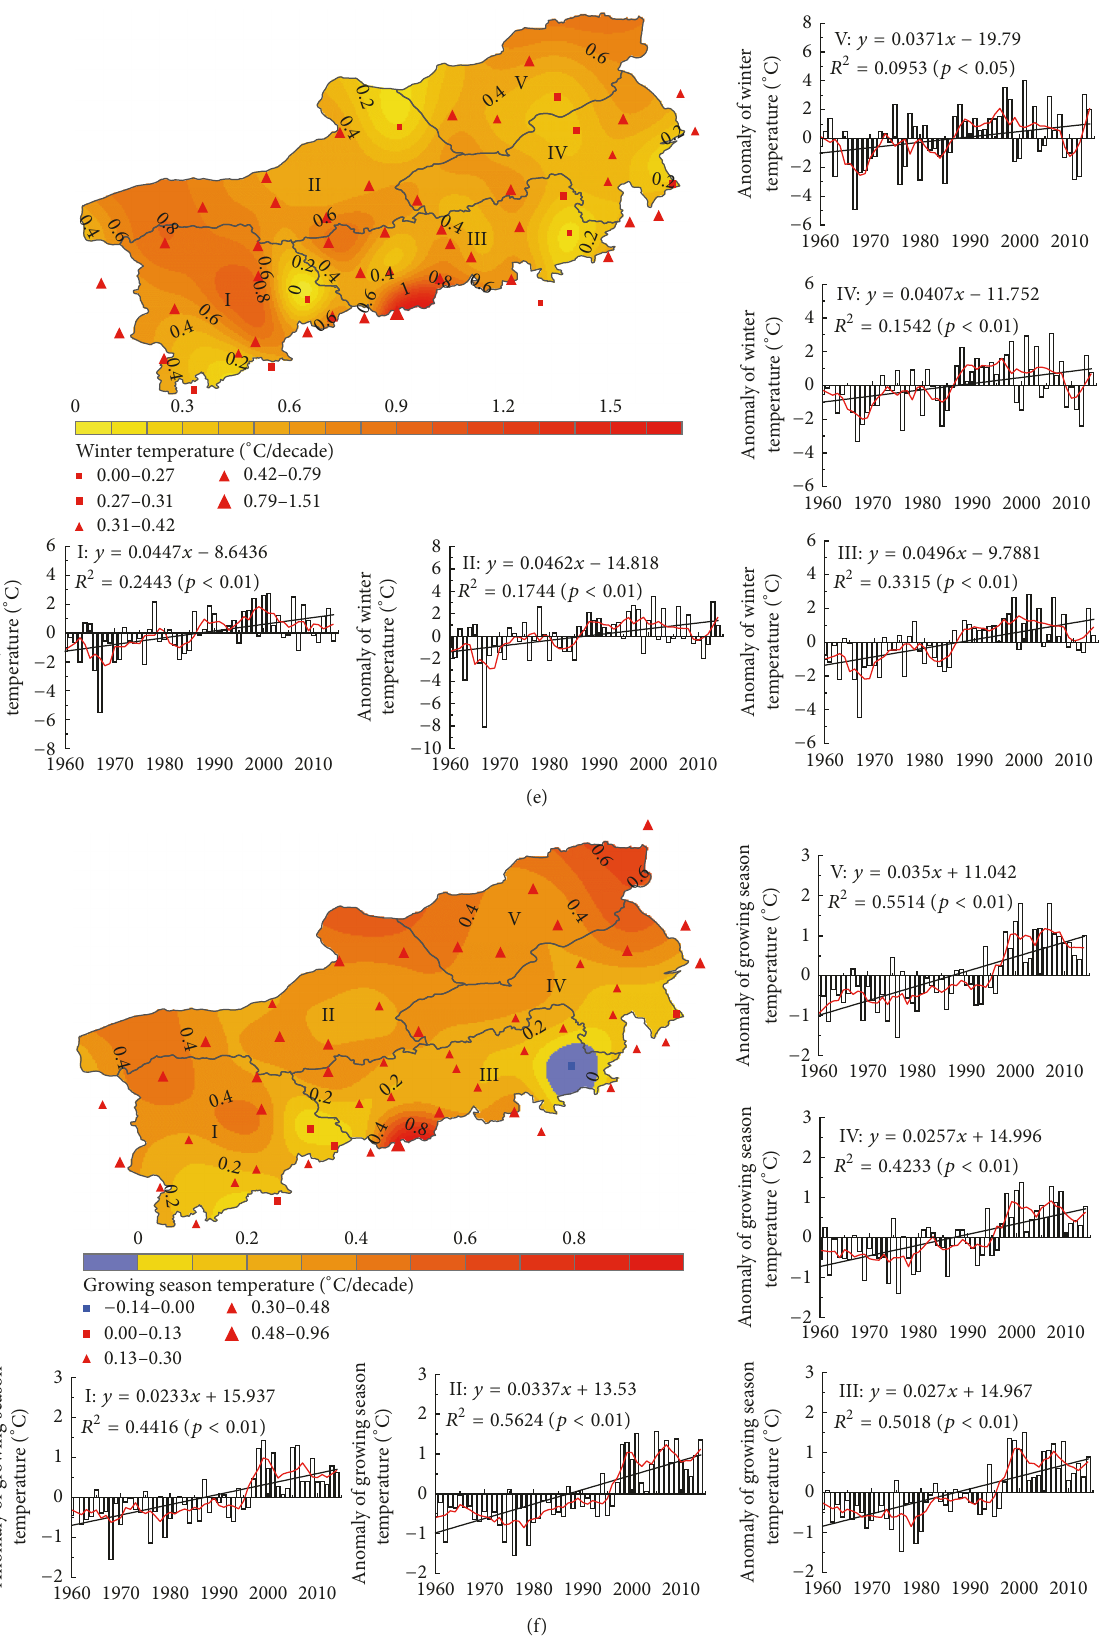
Figure 5: Spatial patterns of the trend slopes of mean temperature (1960–2014) over the BTSSR and anomaly of subregional indices curves. The blackline represents linear trends for (a) annual, (b) spring, (c) summer, (d) autumn, (e) winter, and (f) growing season. The redline represents the 5-year moving